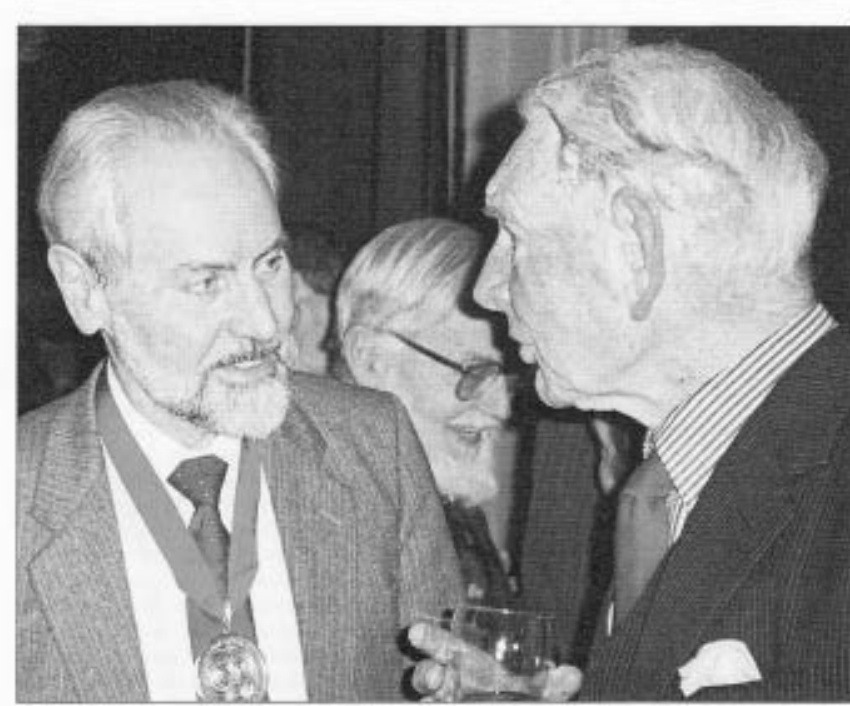
Figure 3 At a reception following the presidential address to the Prehistoric Society, with Professor Sir Grahame Clark (right) and Professor Thurstan Show (background centre), 1 6 February 1 994 (photo by Zoe